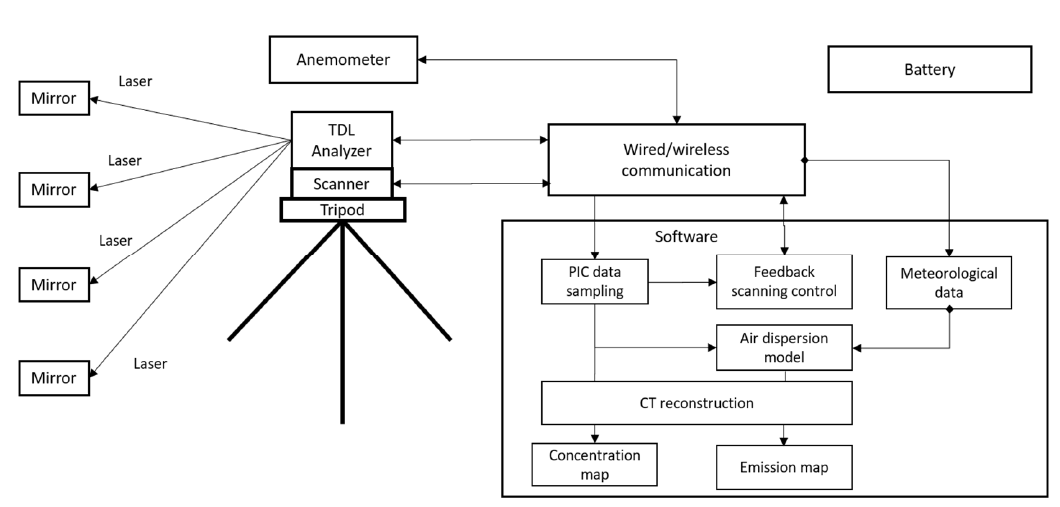
Figure 4. Schematic of the multi ‐ path scanning TDL system.